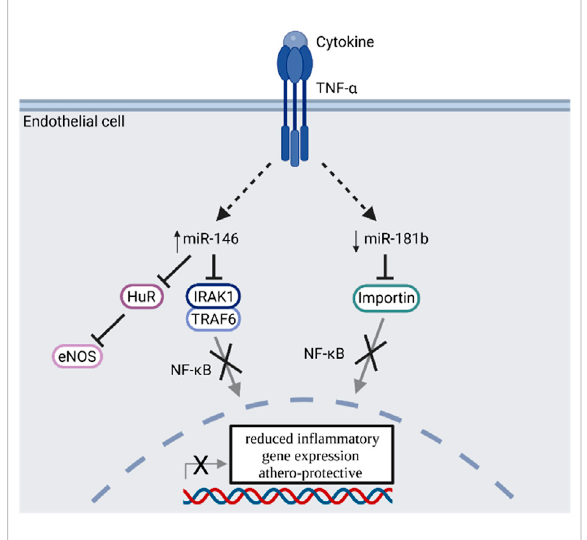
FIGURE 5 TNF- α signal transduction enhances miR-146 and reduces miR-181b expression, which inhibits NF- κ B signaling and is regarded as athero-protective. TNF- α : Tumor necrosis factor alpha; miR: microRNA; HuR: Human antigen R protein; eNOS: endothelial nitric oxide synthase; IRAK1: Interleukin 1 receptor associated kinase 1; TRAF6: TNF receptor associated factor 6; NF- κ B: Nuclear factor kappa B. Scheme was summarized from data in (Feinberg and Moore, 2016). Created with